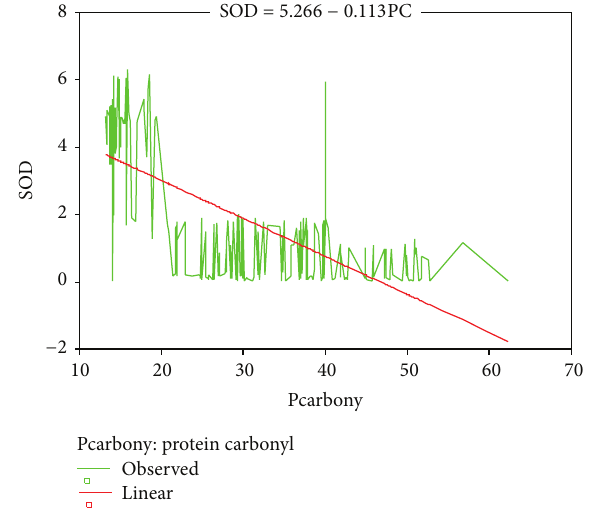
Figure 6: Correlation between SOD and Serum Protein Carbonyl in protein energy malnutrition ( 𝑃 < 0.001 ).